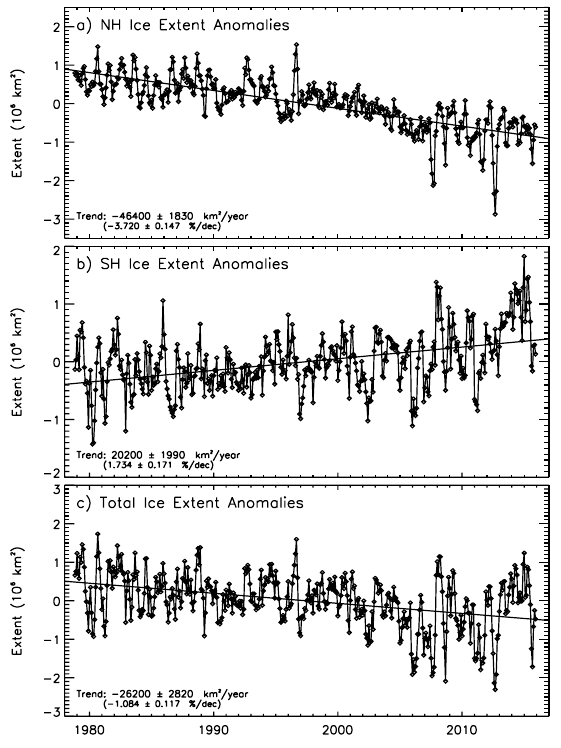
Figure 7. Monthly sea ice extent anomaly in (a) the Arctic; (b) the Antarctic; and (c) both hemispheres and and linear regression line that provides results of trend analysis.